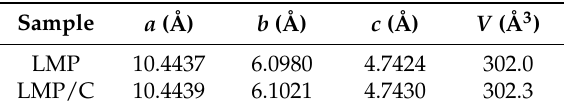
Table 1. Lattice parameters of the prepared LMP and